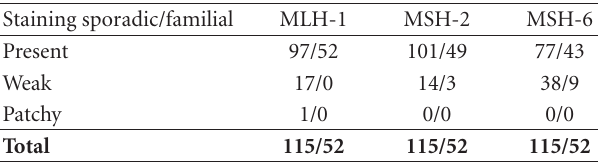
Figure 7: High-powered view demonstrating weak MSH-6 methy- lation in a hyperplastic polyp. Table 6: IHC results of hyperplastic polyps for the mismatch repair proteins.